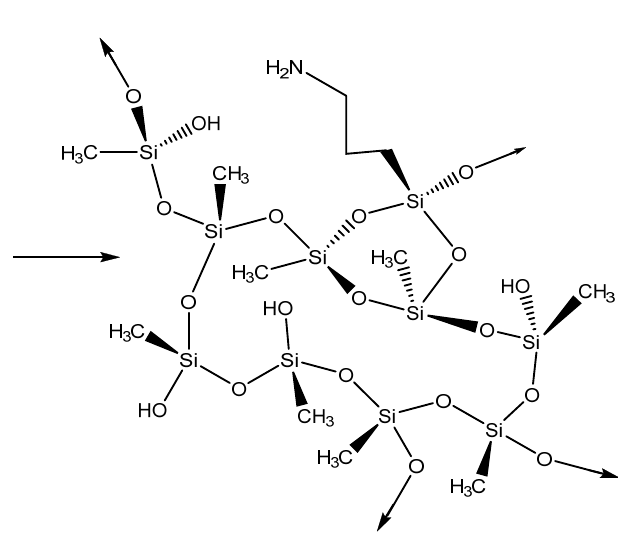
Scheme 2. Illustration of amine-modified silica network of adsorbent